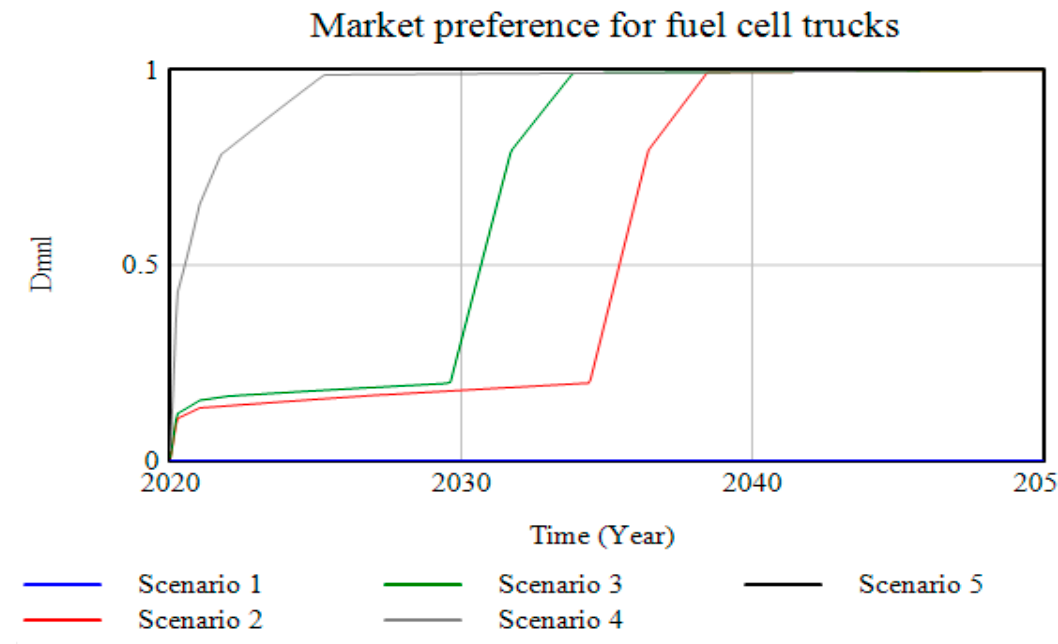
Figure 3. Market Preference for fuel cell trucks.